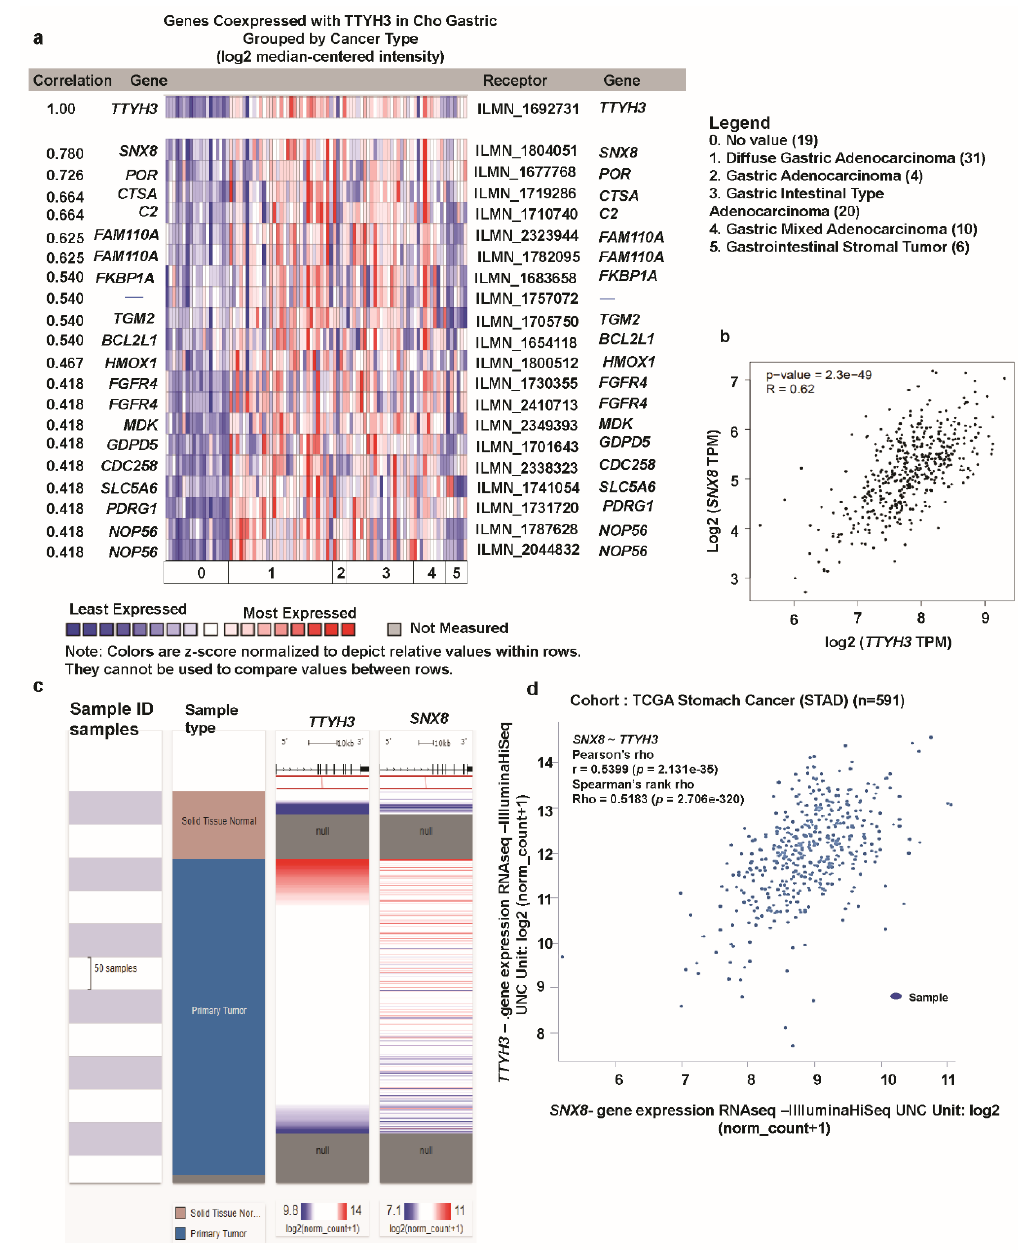
Figure 7. Co-expression profile of the TTHY3 gene in gastric cancer: ( a ) The co-expression gene profile of TTYH3 was analyzed using Oncomine. ( b ) The co-expression analysis was performed between TTYH3 and SNX8 transcript levels in GC tissues using GEPIA web (http: // gepia2.cancer-pku.cn). ( c ) Heat map of TTYH3 and SNX8 mRNA expression across gastric cancer in the TCGA database, determined using UCSC (University of California, Santa Cruz) Xena web. ( d ) Co-expression analysis between TTYH3 and SNX8 mRNA expression in gastric cancer determined using UCSC Xena web.